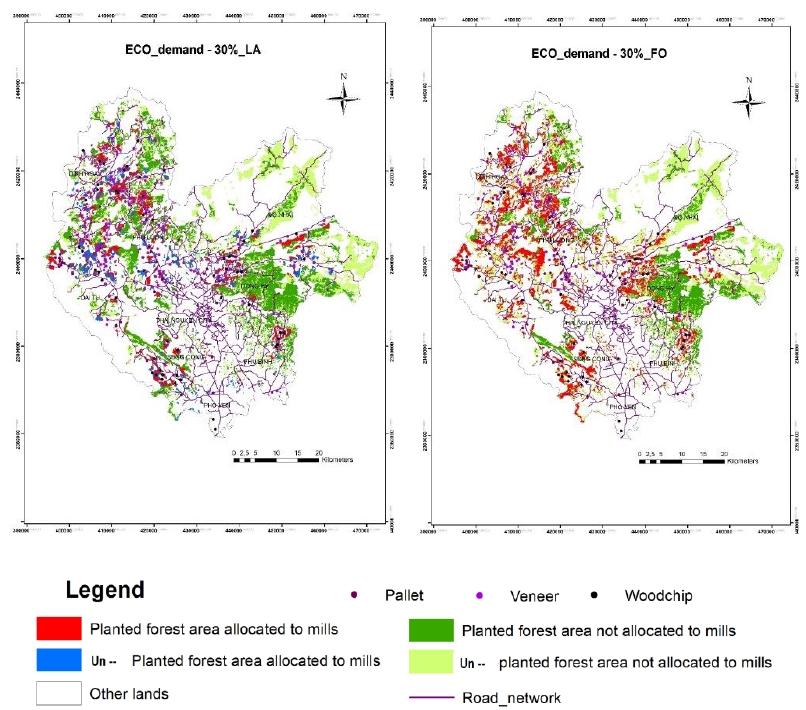
Figure 7. Spatial distribution of land area allocated by decreasing timber demand 30% under the landscape approach (_LA) and the current forest approach (_FO).